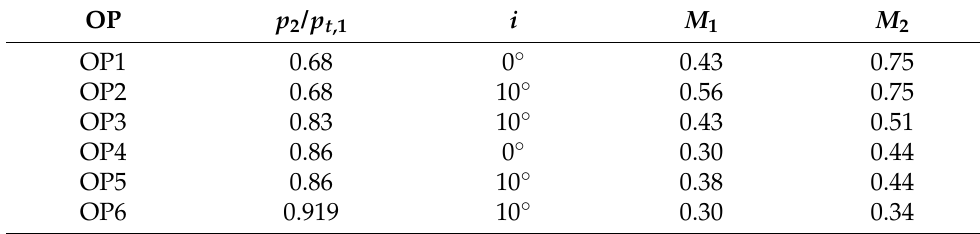
Table 1. Definition of the operating